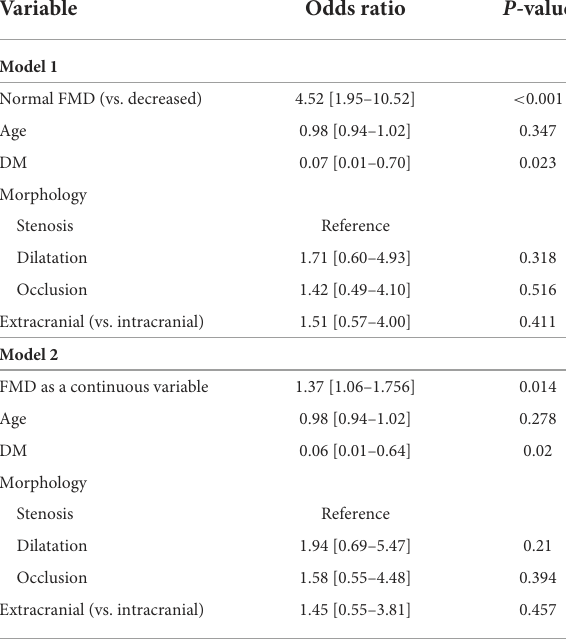
TABLE 2 Multivariable analysis to determine the association between flow mediated dilatation values and spontaneous arterial